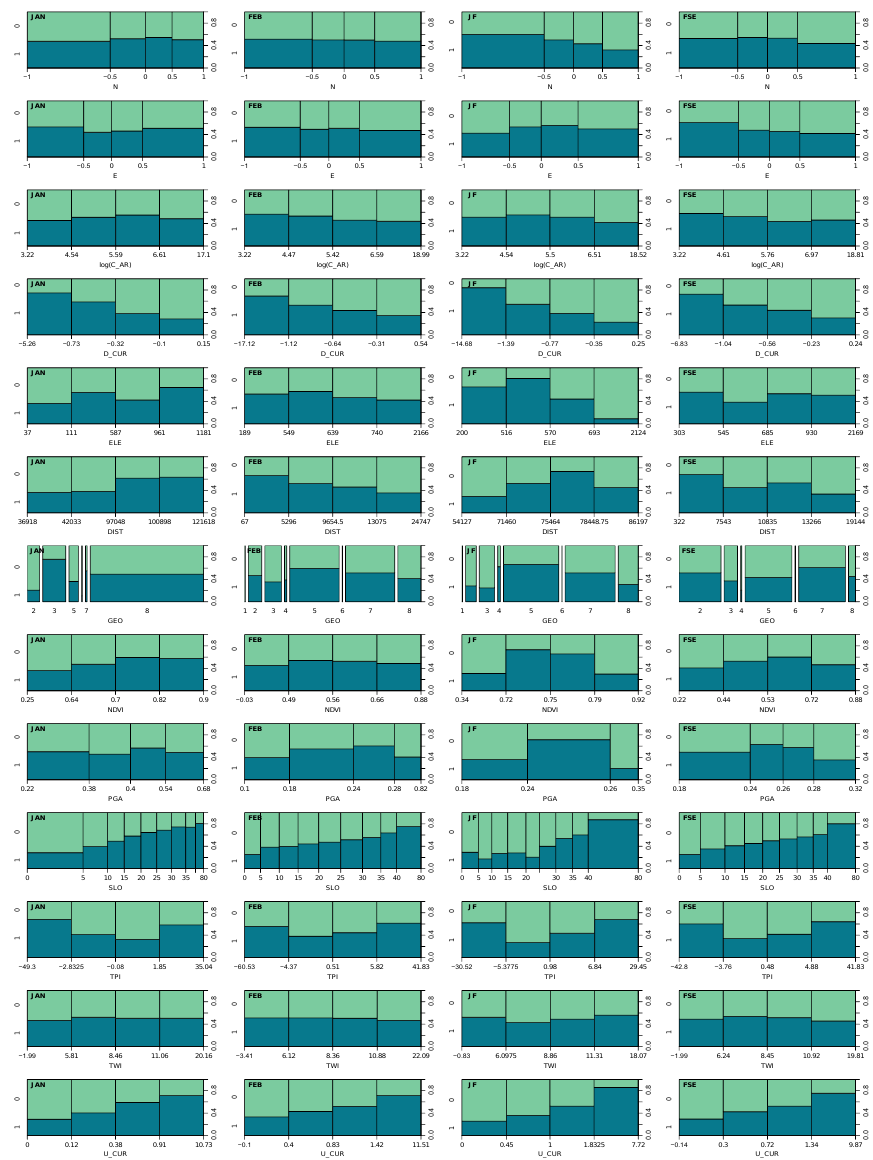
Figure 9. Conditional density plots of the training samples extracted from the datasets JAN, FEB, JF and FSE. The plots reveal the relative frequency of non-LIP (0) and LIP (1) pixels within the predictor classes. The width of the bars shows the relative frequency of each class. Lithology units: (1) GEO1 incoherent soils/rocks, (2) GEO2 soft rocks, (3) GEO3 hard rocks, (4) GEO4 medium rocks, (5) GEO5 very soft soils, (6) GEO6 soft soils, (7) hard soils and (8) GEO8 medium soils.